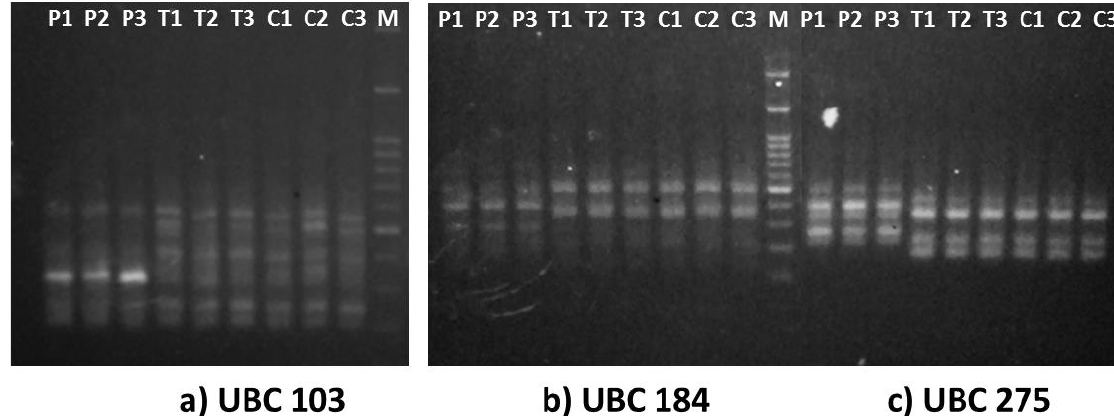
Fig. 5: Sample DNA fingerprints obtained from three RAPD makers: (a) UBC 106 (b) UBC 184 and (c) UBC 275 of A. sativum L. of the Thai (TH), Chinese (CH) and Pingpong (PP) cultivars.